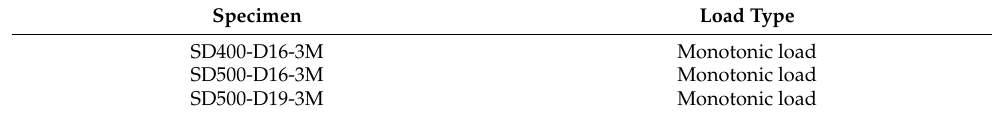
Table 4. Specimens applied with the strain gauge plan.